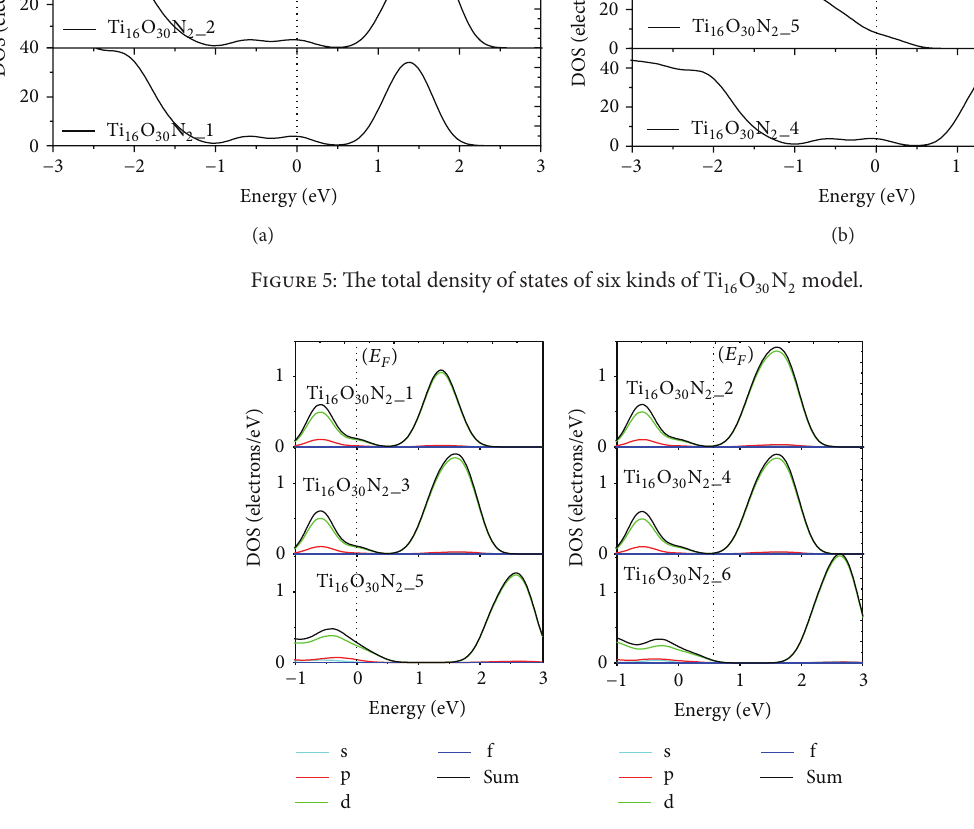
Figure 6: The density of states of Ti